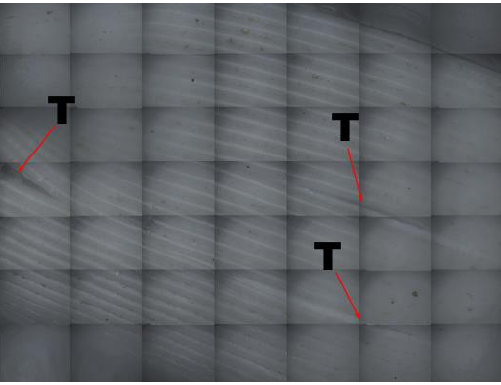
Figure 17. Local distortion and cracking diagram of the grating after component compression.